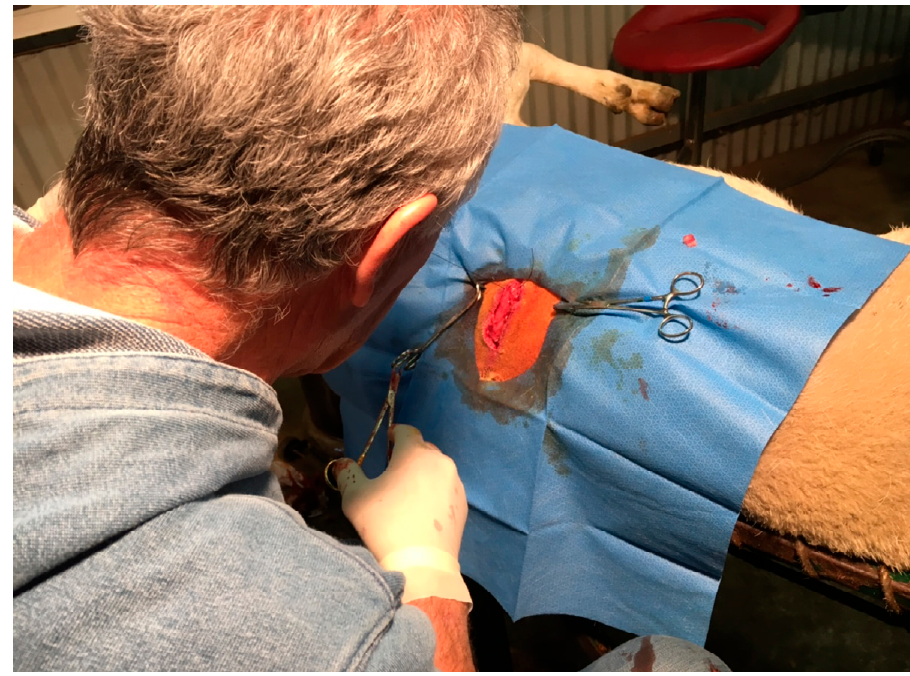
Figure 2. Muscle biopsy sampling technique in Tattykeel Australian White sheep.